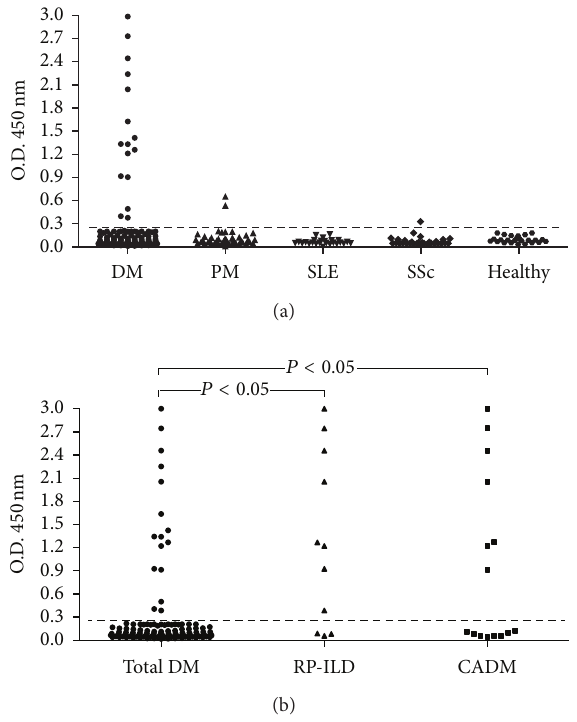
Figure 2: Representation of the anti-MDA5 ELISA test results in patients with dermatomyositis (DM) ( 𝑛 = 117 ) and controls groups: polymyositis (PM) ( 𝑛 = 45 ), systemic sclerosis (SSc) ( 𝑛 = 30 ), systemic lupus erythematosus (SLE) ( 𝑛 = 25 ), and healthy controls ( 𝑛 = 25 ). Panel (b) shows anti-MDA5 ELISA of patients with DM ( 𝑛 = 117 ) and individual subgroups of DM patients: rapidly progressive-interstitial lung disease (RP-ILD) ( 𝑛 = 11 ) and clinically amyopathic dermatomyositis (CADM) ( 𝑛 = 15 ). The cut-off value for a positive result was established at 0.188 absorbance units which corresponded to 2 standard deviations above the mean value obtained for the 25 healthy controls (dashed